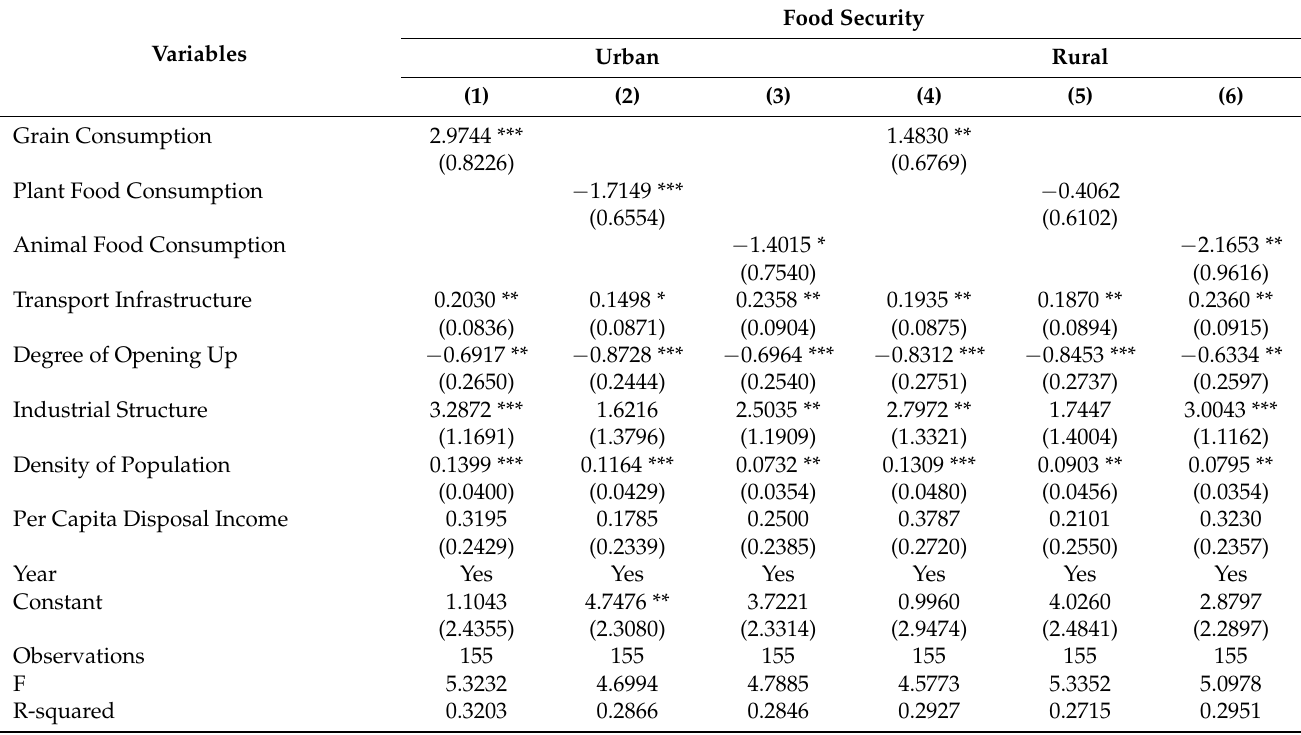
Table 9. Estimation of urban-rural heterogeneity